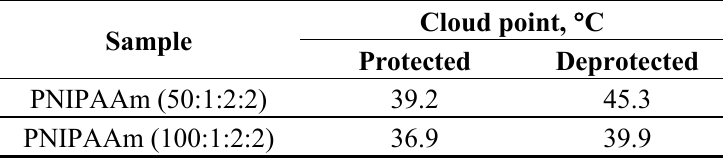
Table 4. Influence of end groups on the cloud point of the PNIPAAm macroinitiators. Measurements were carried out with a 3 mg/mL